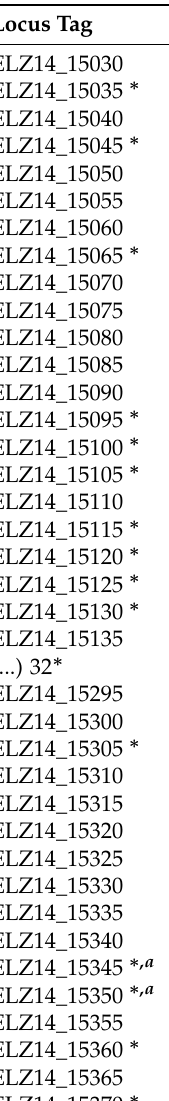
Table 3. Annotation of P. brassicacearum 3Re2-7 singleton